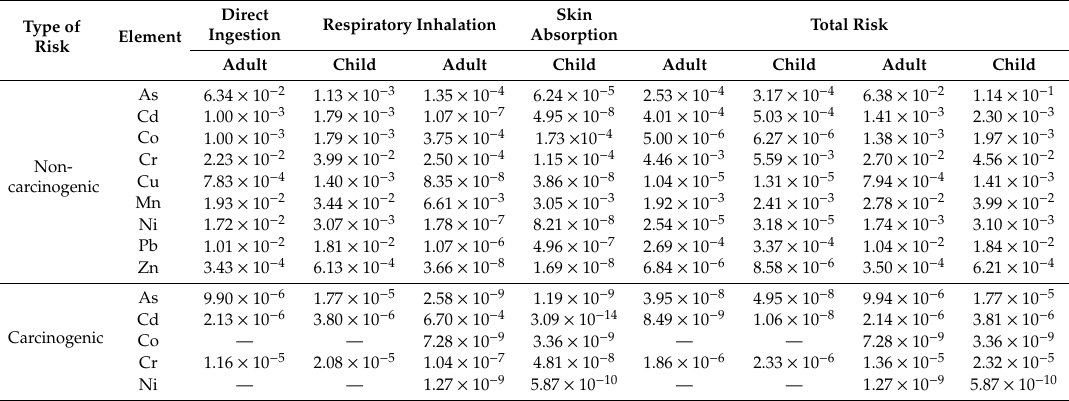
Table 7. Assessment of the health risks for adults and children under di ff erent exposure